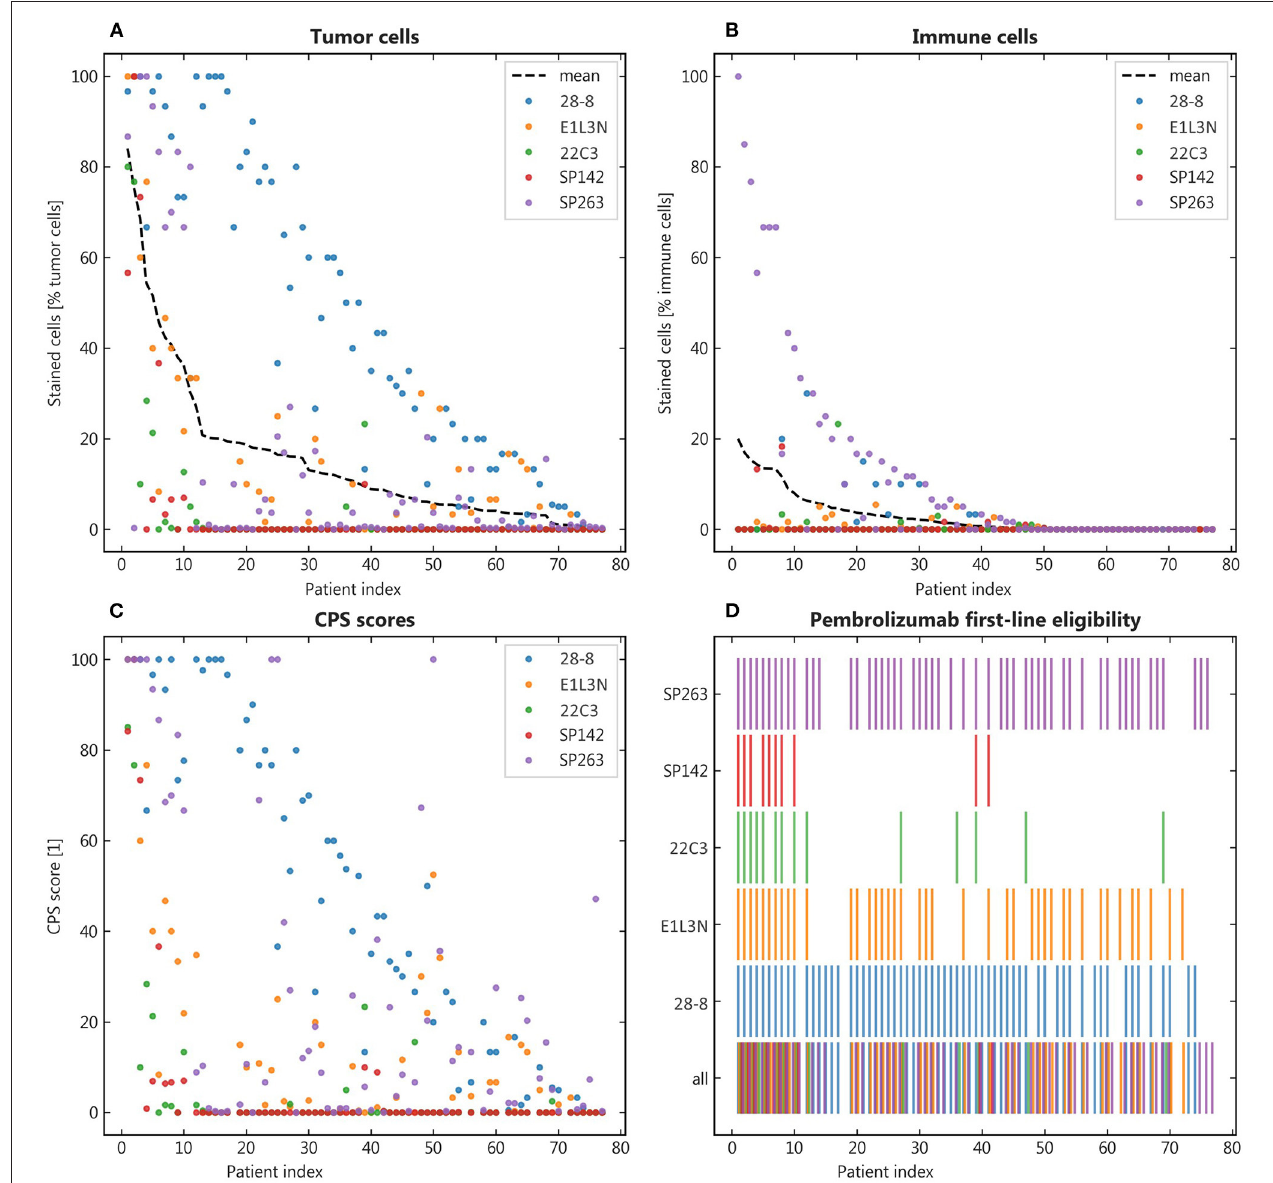
FIGURE 3 | Qualitative results. (A,B) : Patients were ranked by their mean positive tumor and immune cells respectively to facilitate comparison across the different antibody clones; (C) : The combined positive score (CPS) was calculated for each patient and the resulting eligibility for pembrolizumab portrayed in binary representation (color = eligible) (D)